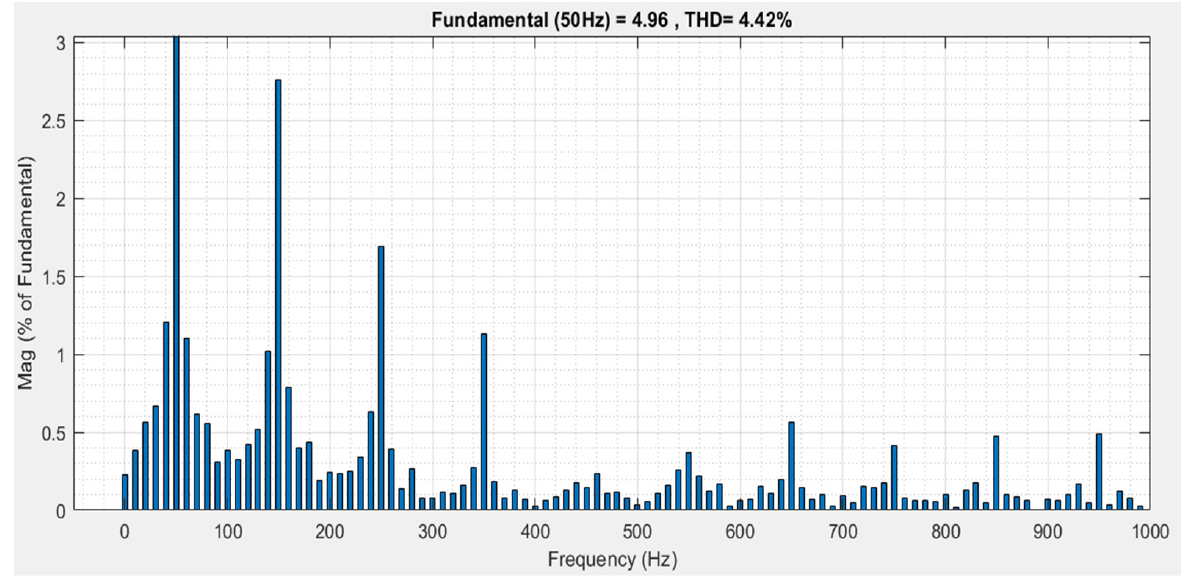
Figure 14. Inductor current waveforms for L 1 = 5 mH, L 2 = 0.5 mH, and L 3 = 0.05 mH.